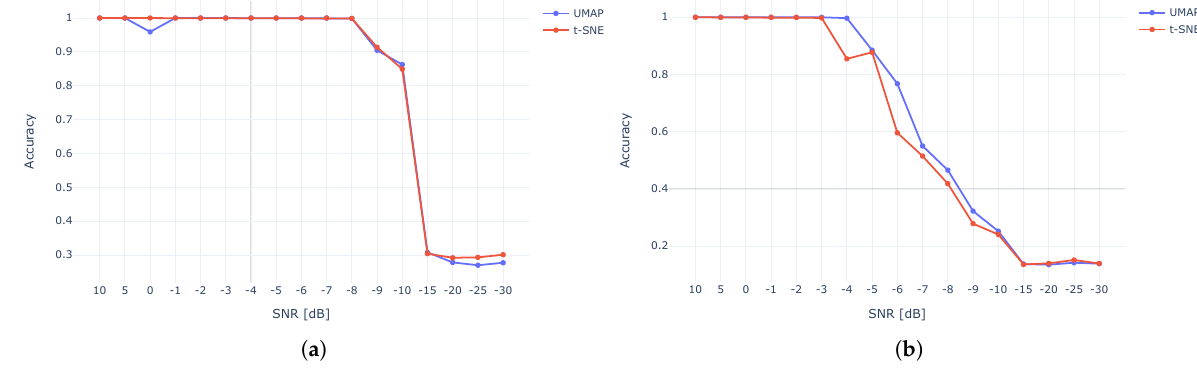
Figure 15. t-SNE and UMAP accuracy for WST ( a ) and CWT ( b